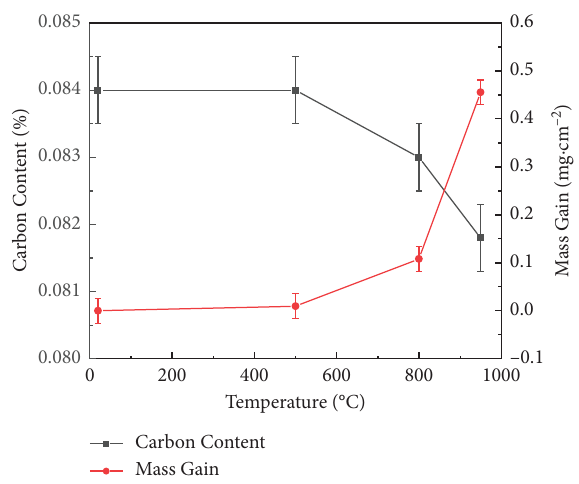
Figure 3: Mass gains and carbon content of the alloy 800H after the corrosion